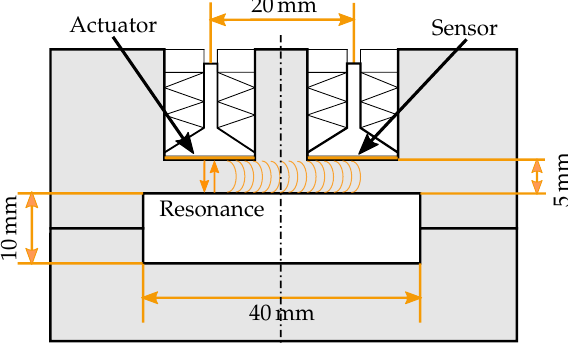
Figure 3. Dimensions of the tool with integrated sensors and acoustic resonance.